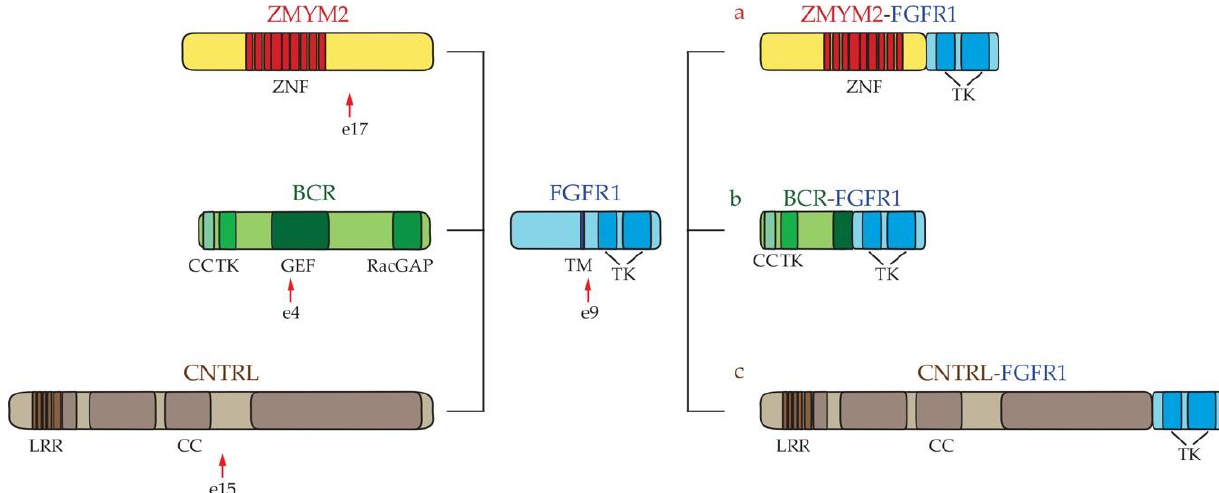
Figure 3. Schematic representation of FGFR1 fusion rearrangements. ( a ) ZMYM2-FGFR1 ; ( b ) BCR-FGFR1 ; ( c ) CNTRL-FGFR1. The arrows indicate the position of breakpoints of FGFR1. BCR = breakpoint cluster region; CC = Coiled–Coil; CNTRL = Centriolin; FGFR1 = fibroblast growth factor receptor 1; GEF = Guanine Nucleotide Exchange Factor; RacGAP = COOH-terminal GTPase Activating Protein (GAP) domain; TK = Tyrosine Kinase; LRR = Leucine-Rich Repeat; ZNF = Zing Finger; ZMYM2 = Zinc finger MYM-type protein